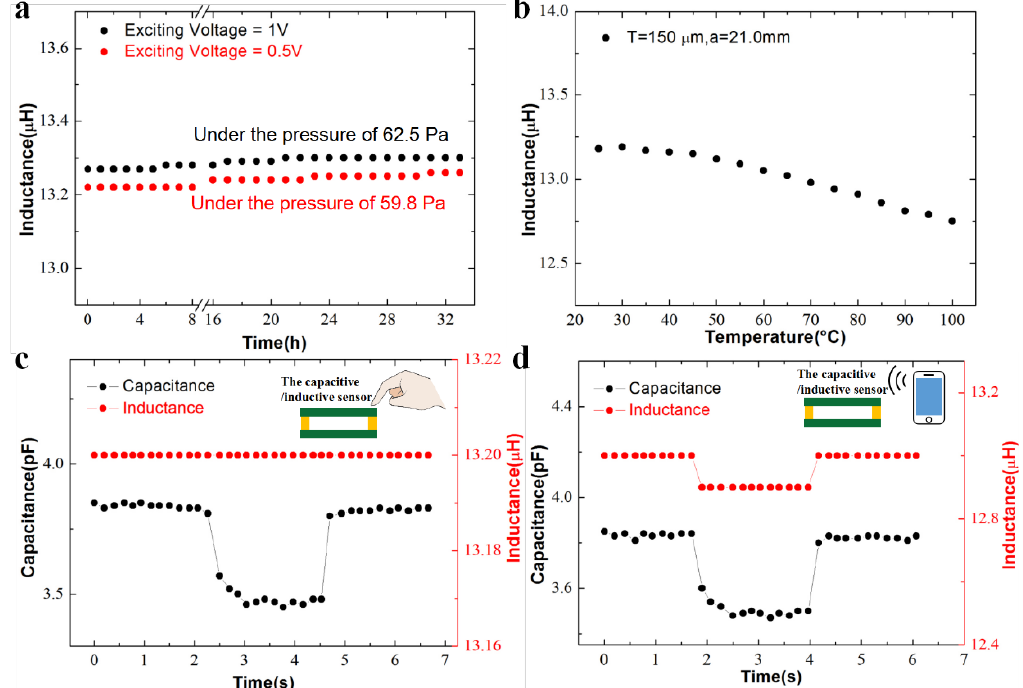
Figure 5. Characterization of the device stability. The output responses of the sensor with a film thickness of 150 μm and an edge length of 21.0 mm to ( a ) a constant pressure over 32 h at different exciting voltages of 1 and 0.5 V. ( b ) Temperature varying from 25 to 100 °C, ( c ) the human finger in comparison with the performance of a capacitive pressure sensor with a same dimension, and ( d ) an electromagnetic interference (EMI) device in comparison with the performance of the same capacitive pressure sensor. The exciting voltage in experiments of ( b – d ) is 1 V.